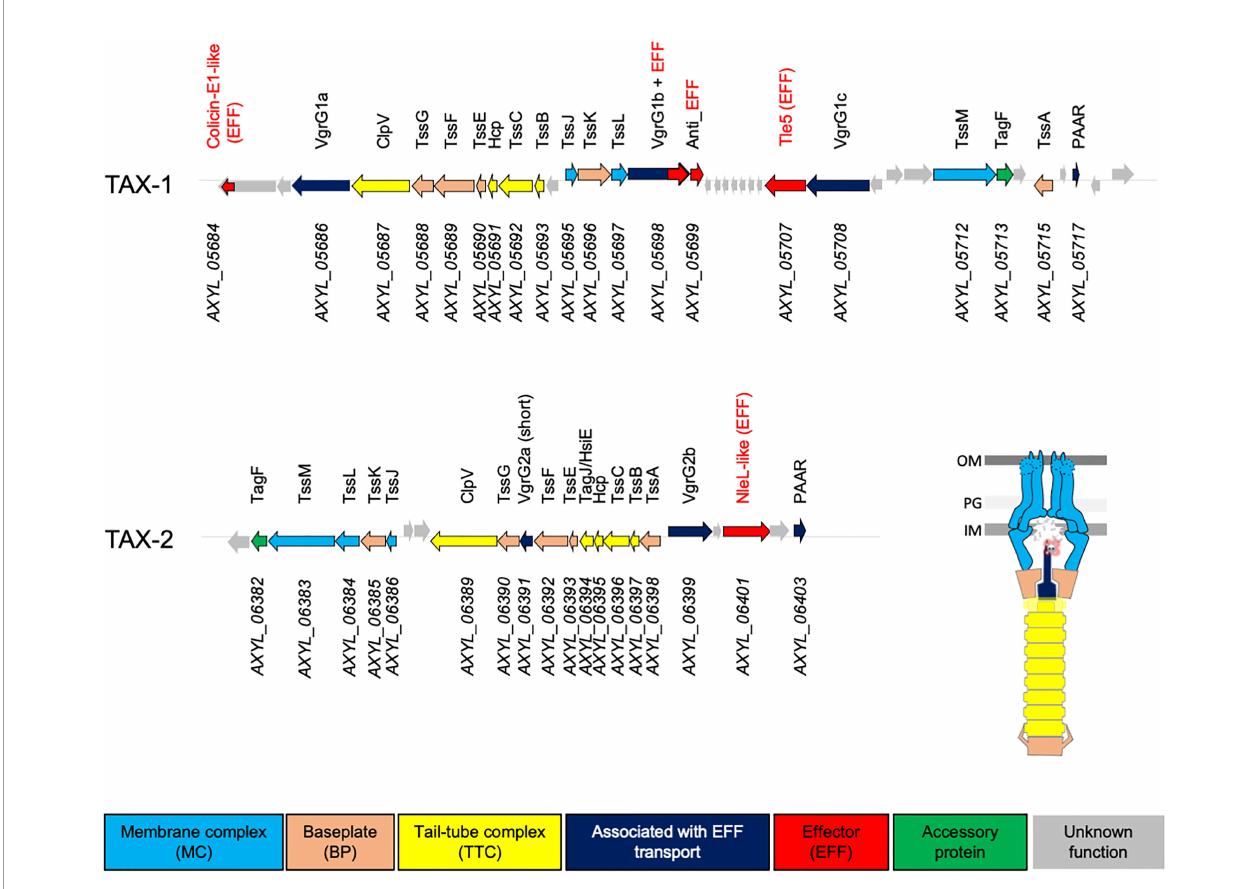
FIGURE 1 | Genetic organization of the TAX-1 and TAX-2 operons in A8. Genes depicted as arrows are labeled with annotated numbers (below) and when applicable (homologous to known T6SS gene), the given name according Tss/Tag protein nomenclature (above). Arrows are color-coded based on predicted function: membrane complex (MC), baseplate (BP), and tail-tube complex (TTC), associated with EFF transport, effector (EFF), accessory protein, and unknown function are colored in light blue, orange, yellow, dark blue, red, green, and gray, respectively. The scheme represents the architectural model of the T6SS